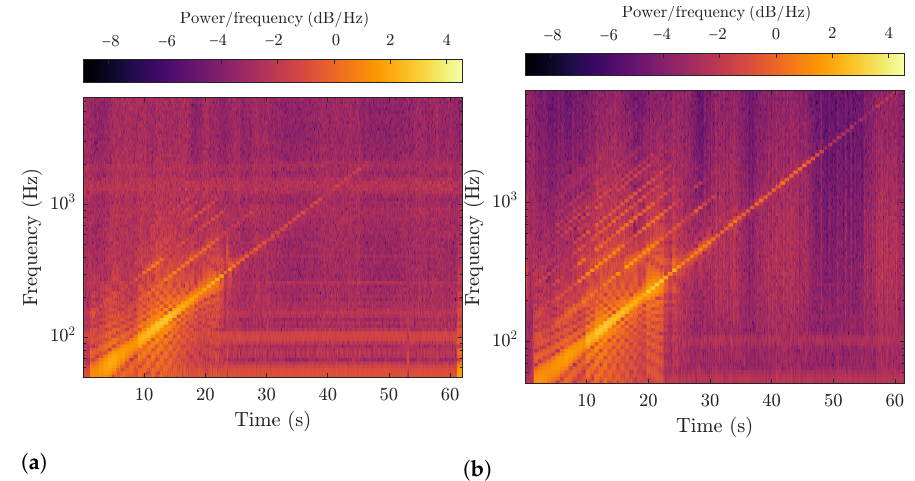
Figure 9. Spectrogram of test signals acquired by myRIO ( a ) and Startech ( b ). Confusion matrix evaluated on the testing dataset